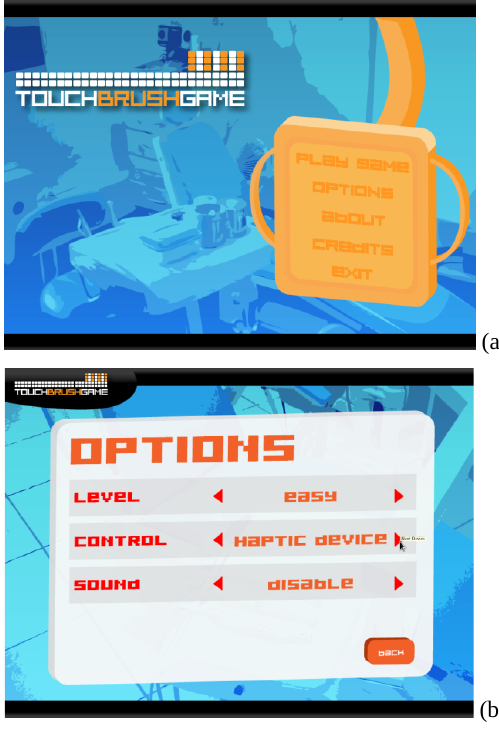
Fig. 8. Main display and options menu.